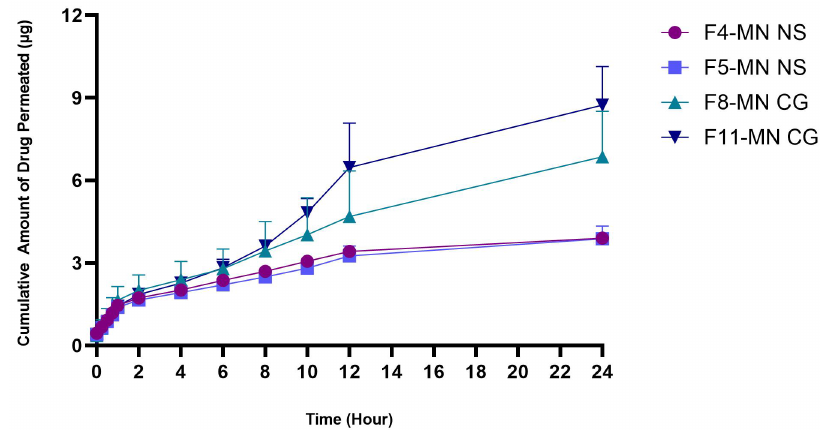
Figure 14. Thermogram DSC of ketoprofen-loaded NS and MN.